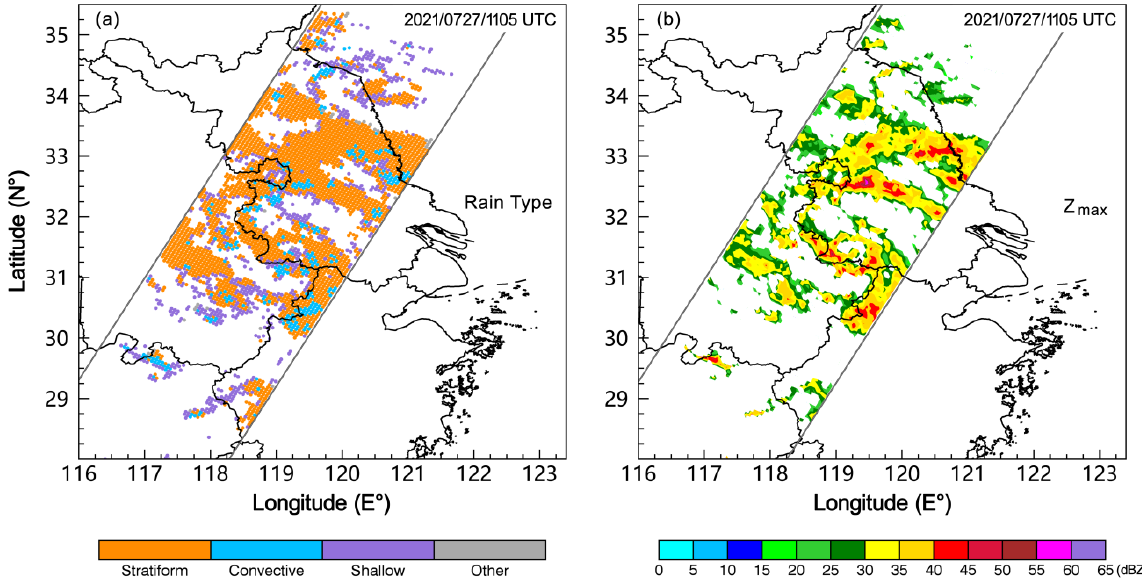
Figure 2. GPM instantaneous observation at 1105 UTC: ( a ) rain types (convective, stratiform, shallow, and other) and ( b ) maximum equivalent radar reflectivity (dBZ). The paralleled gray lines represent the boundaries of GPM scanning path.